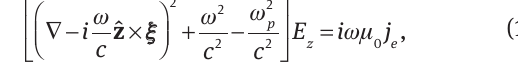
/ 5.63. a c ω ≈ (A) “Photonic graphene” with ω , pb = 0 and / 1.09. a c ω ≈ (C) “Photonic graphene” with a broken TRS such ,2 p p ,1